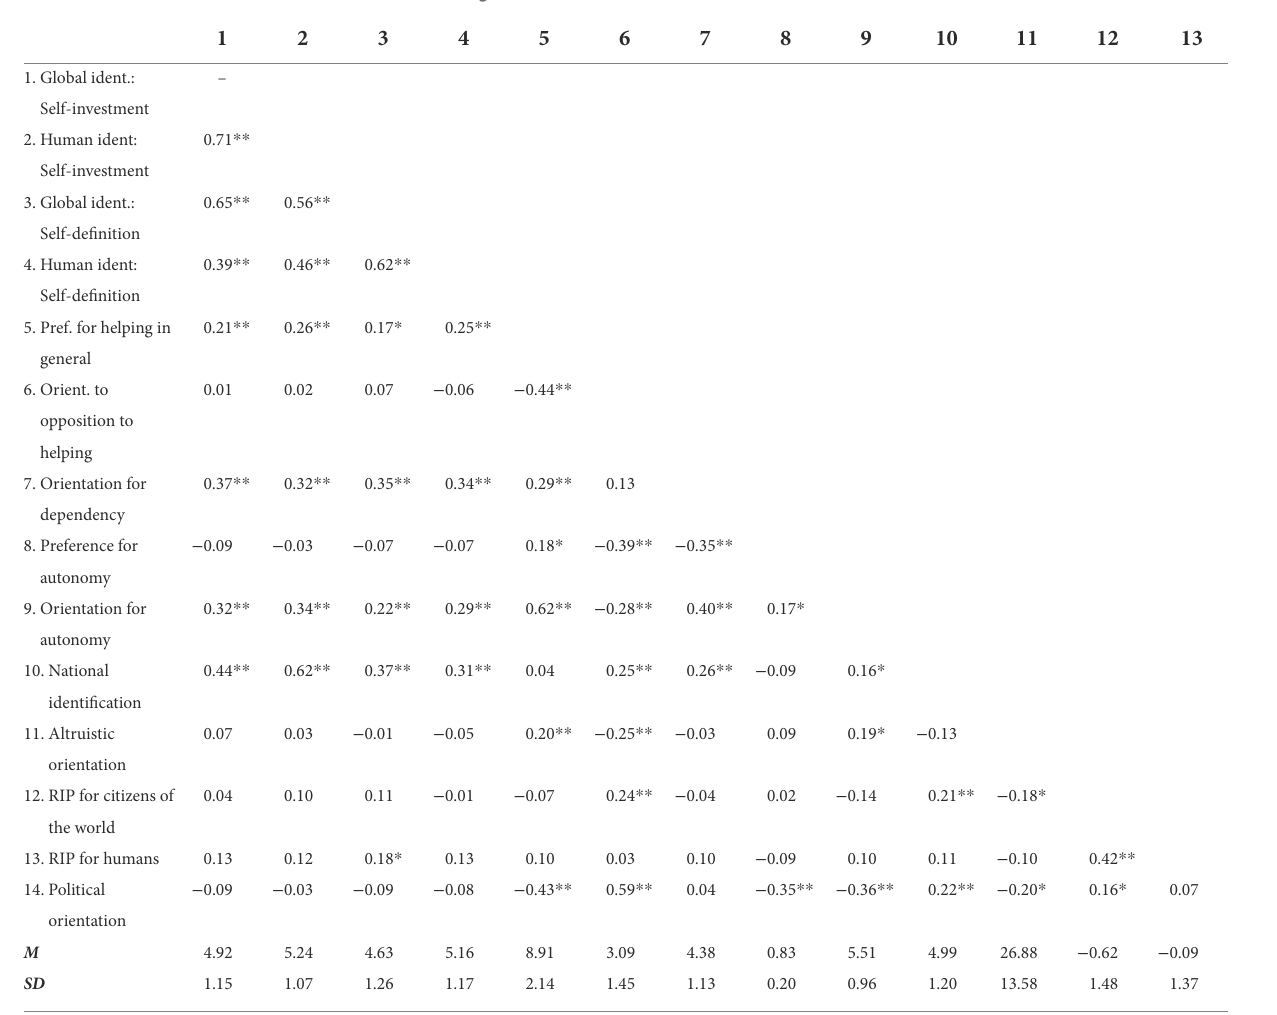
TABLE 1 Means, SD s, and zero-order correlations among main